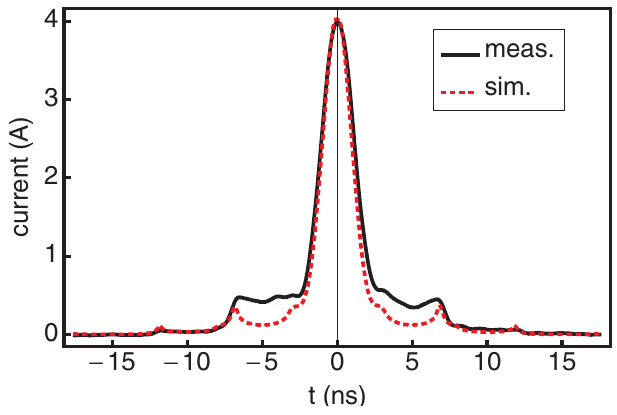
FIG. 4. (Color) Example of a measured bunch profile in RHIC after the ramp when collisions are turned on. We show also the simulated profile used as starting conditions in the simulations. It was generated by letting an initially Gaussian bunch circle in the machine under the influence of